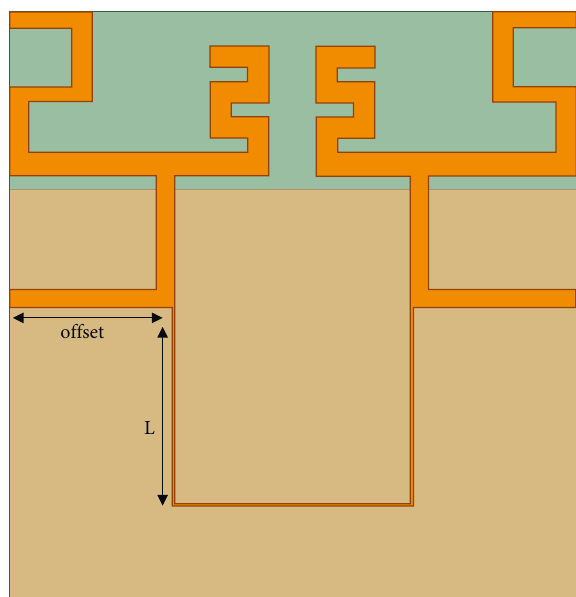
Figure 11: Structure of antenna#2 with NL.